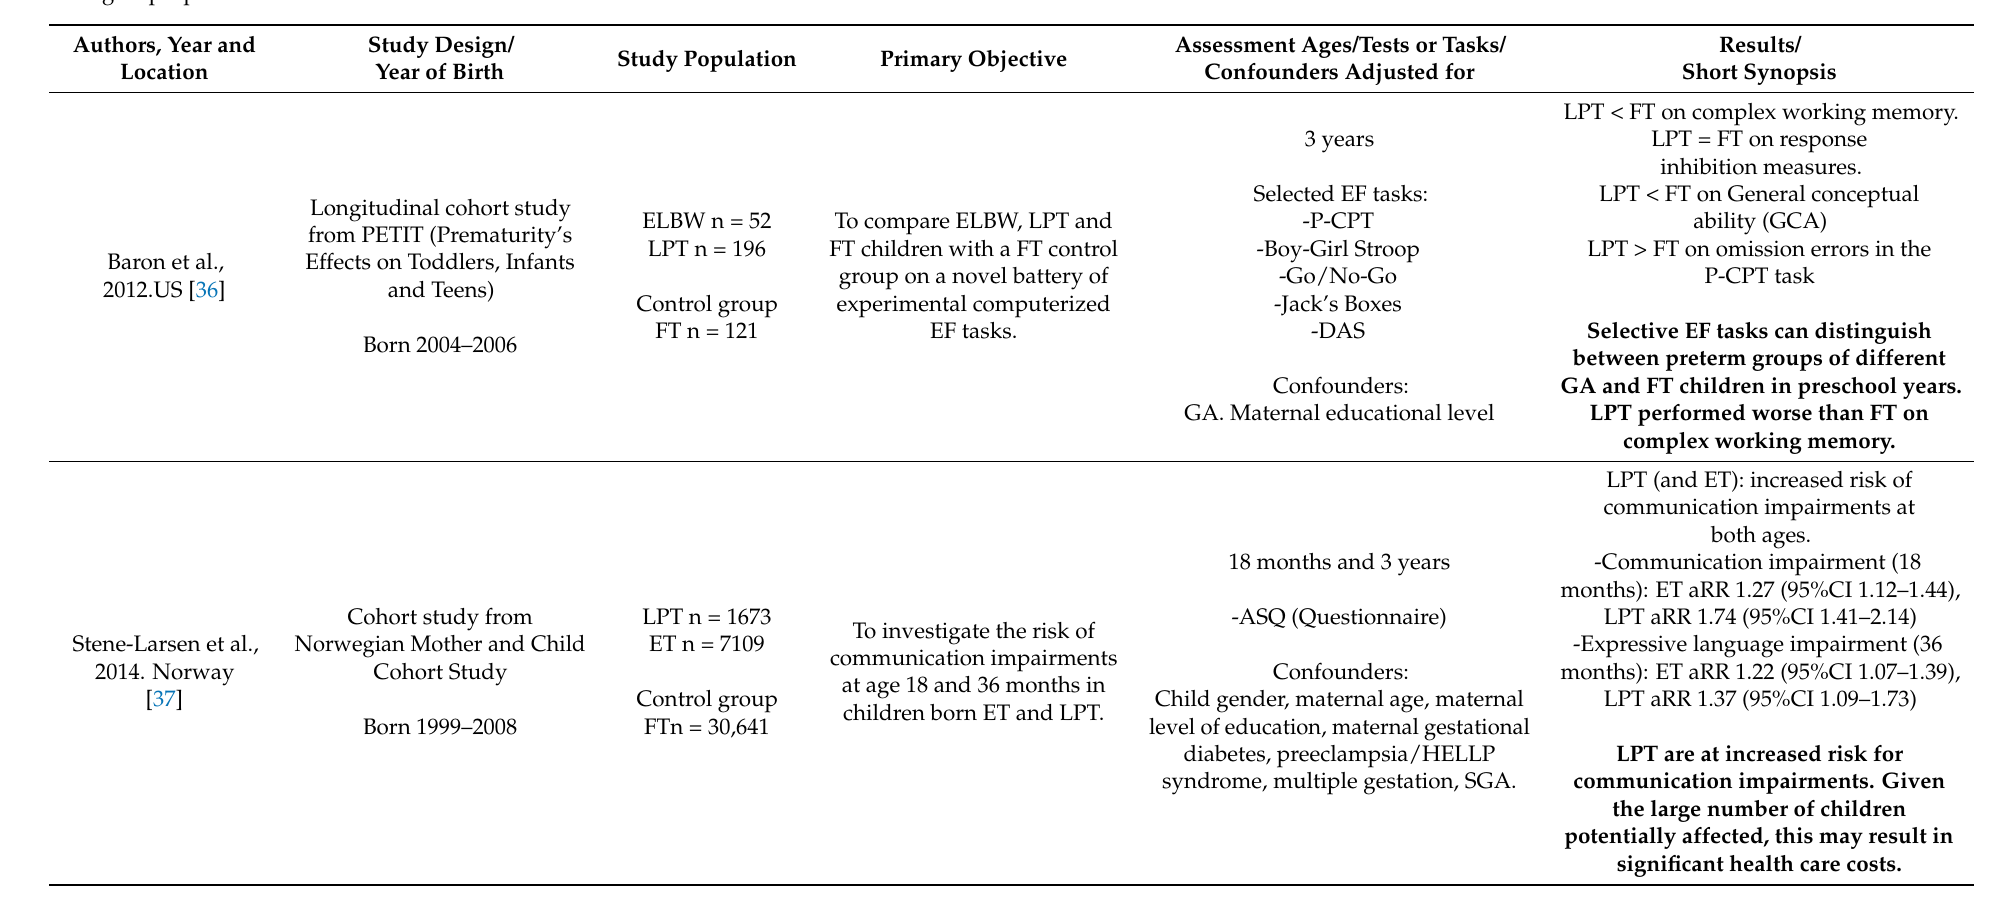
Table 1. Neuropsychological and academic performance outcomes: Characteristics of the selected studies in these domains, where cognitive and language functions are included. Studies have been ordered by main age of the assessment, starting from age 3 years. The results column includes a short synopsis specifically highlighting the main findings related to late preterm groups’